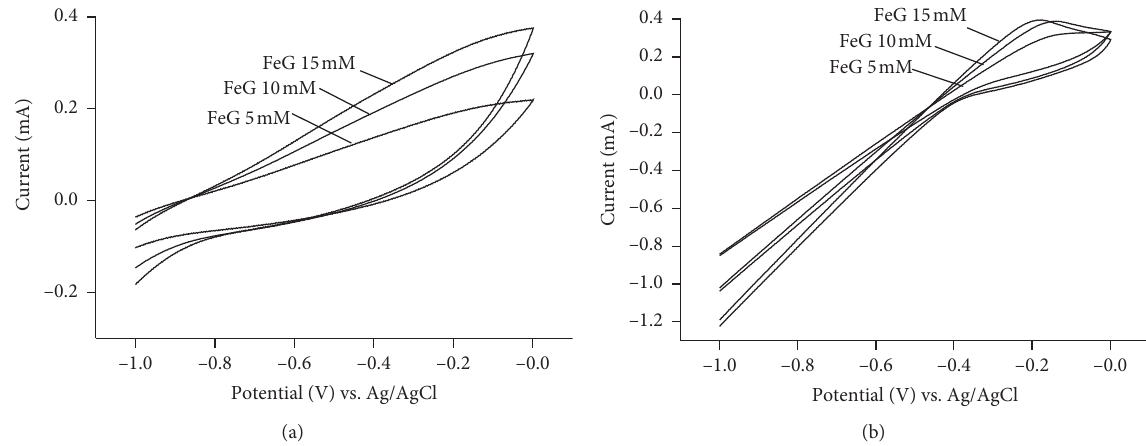
Figure 3: Cyclic voltammograms of (a) FeG solution and (b) FeG-Ac 2.5% solution with varying concentrations of FeG (5, 10, and 15mM) at v �